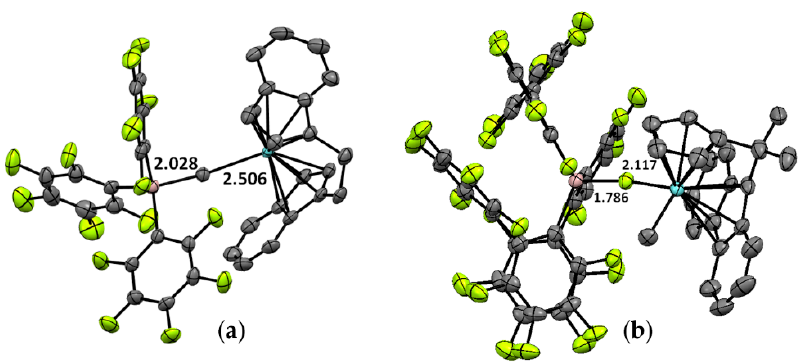
Figure 17. Molecular structures of the complexes ( a ) {[(CH 2 CH 2 )Ind 2 ]ZrMe} + [MeAl(C 6 F 5 ) 3 ] − ( Zr18 ) [160] and ( b ) [Me 2 C(Cp)(Flu)]ZrMe] + [FAl(2-C 6 F 5 C 6 F 4 ) 3 ] − ( Zr19 ) [22].